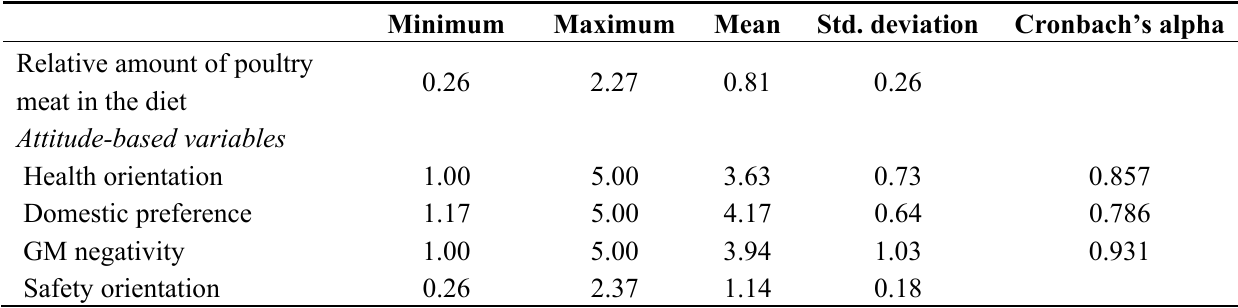
Table 2. Descriptive statistics for the poultry use variable and the attitude-based variables, including Cronbach’s alphas where